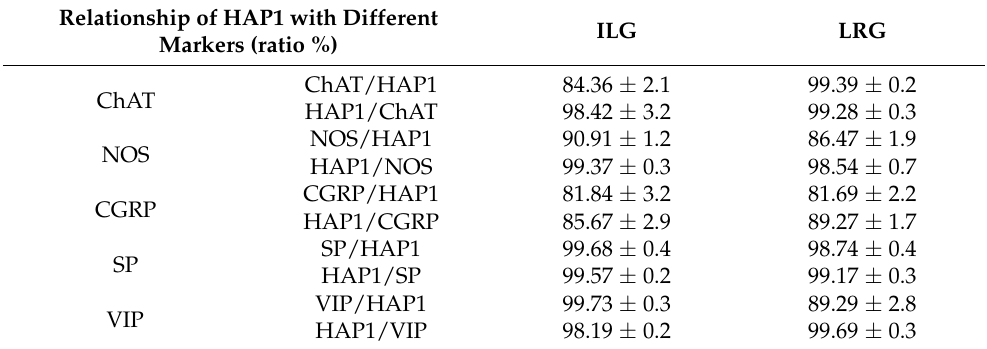
99.69 ± 0.3 99.69 ± 0.3